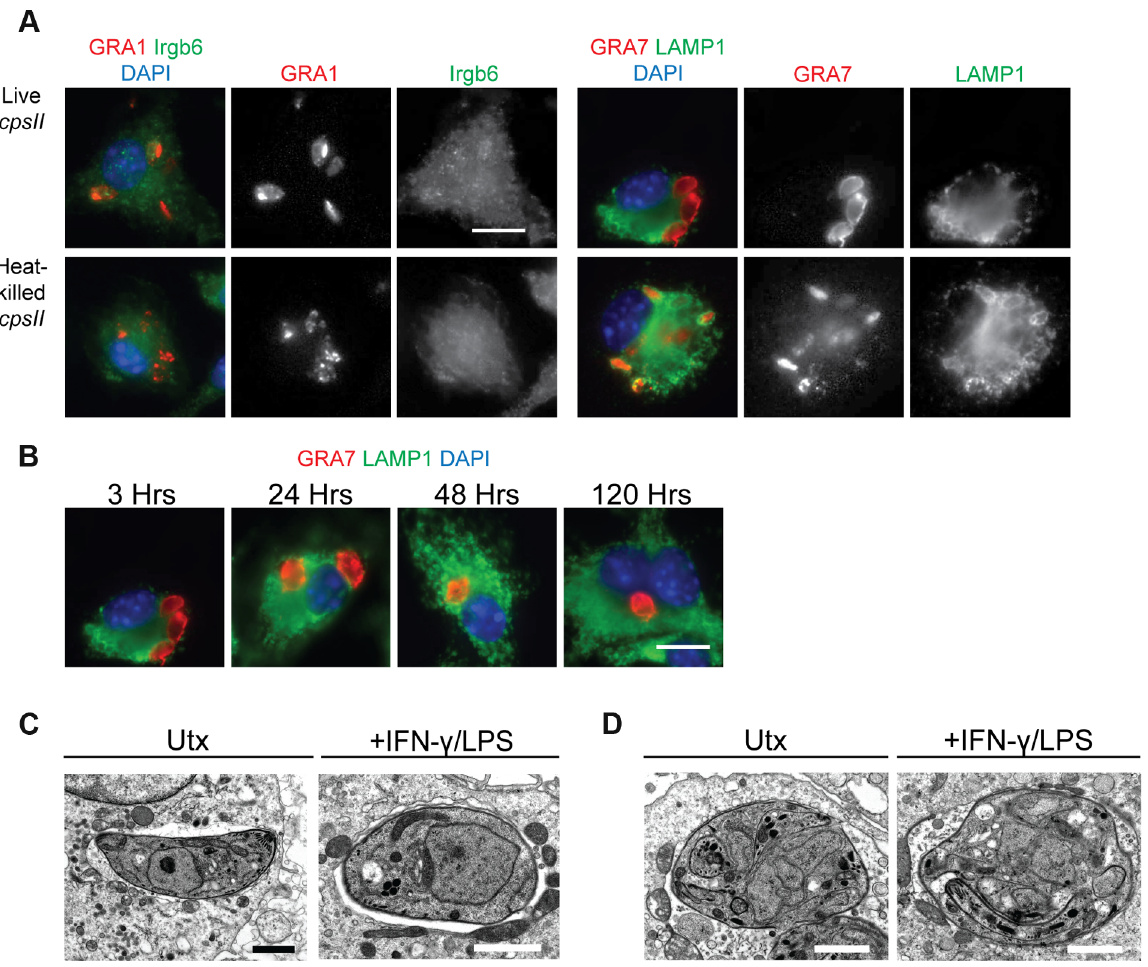
Figure 2. The fate of heat-killed and live cpsII parasites in host cells. C57BL/6 bone marrow derived macrophages were infected with cpsII parasites and examined using immunofluorescence assays (a). Bone marrow-derived macrophages activated with IFN- c (100 U/ml) and LPS (0.1 ng/ ml) were infected with freshly lysed or heat-killed parasites for 3 hours. Intracellular parasites were stained for host Irgb6 or LAMP1 recruitment in green. Parasites were stained with a mouse monoclonal antibody to GRA1 to identify the parasitophorous vacuole or rabbit polyclonal sera against GRA7 in red. IFN- c and LPS activated bone marrow-derived macrophages were infected with freshly lysed cpsII parasites and fixed at 3, 24, 48 and 120 hours post-infection (b). Parasite vacuoles were identified with rabbit polyclonal sera to GRA7 (red) and host LAMP1 was identified with a rat monoclonal antibody. Scale bar=10 m m. Electron micrograph images of infected macrophages treated with IFN- c (50 units/ml) and LPS (10 ng/ml) or untreated at 2 hours post-infection (c). Parasites persist in intact vacuoles and do not display blebbing or disruption of the parasitophorous vacuole. Some cpsII parasites were found to exhibit non-productive cell division in IFN- c and LPS- treated or untreated macrophages when examined 24 hours post-infection (d). Scale bars=1.5 m